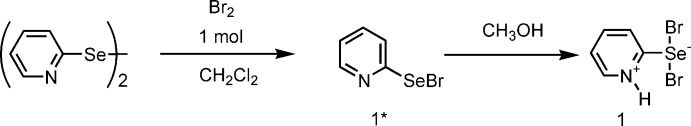
Synthesis of 1H-pyridine-2-selenenyl dibromide 1 by the bromination of bis­(pyridin-2-yl) diselenide in methyl­ene chloride.